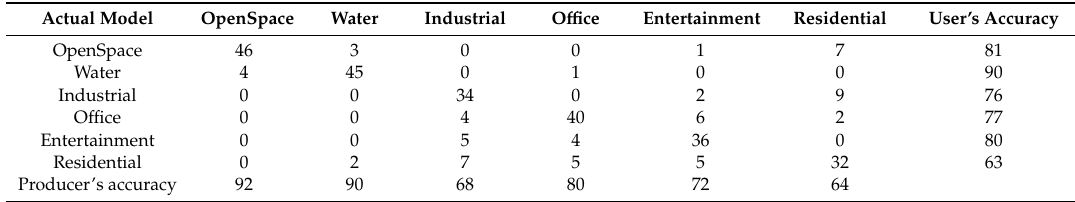
Table A2. Confusion matrix of decision tree classified map using integration of remote and social sensing (without data cleaning).